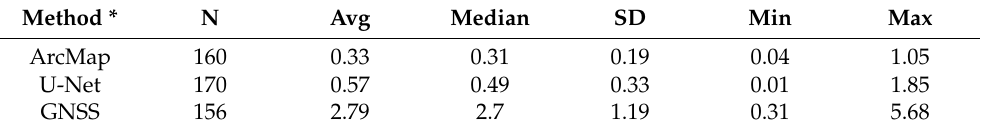
Table 5. Comparison of the trapping pit positioning data digitized manually from the ALS-5p visualizations with the data gathered using three observer independent methods (units in